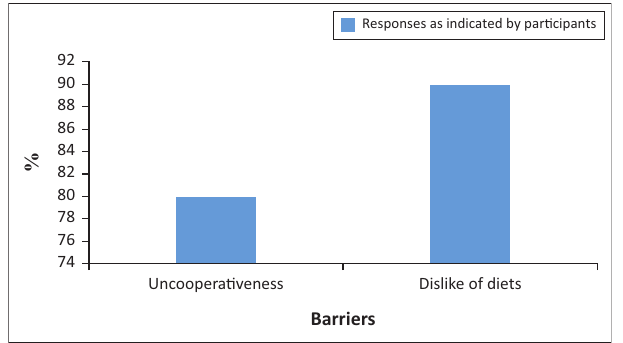
FIGURE 2: Barriers to compliance related to